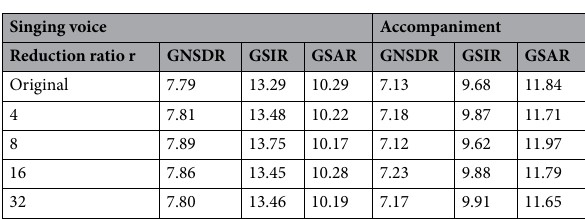
Table 3. The influence of reduction ratio r on separation